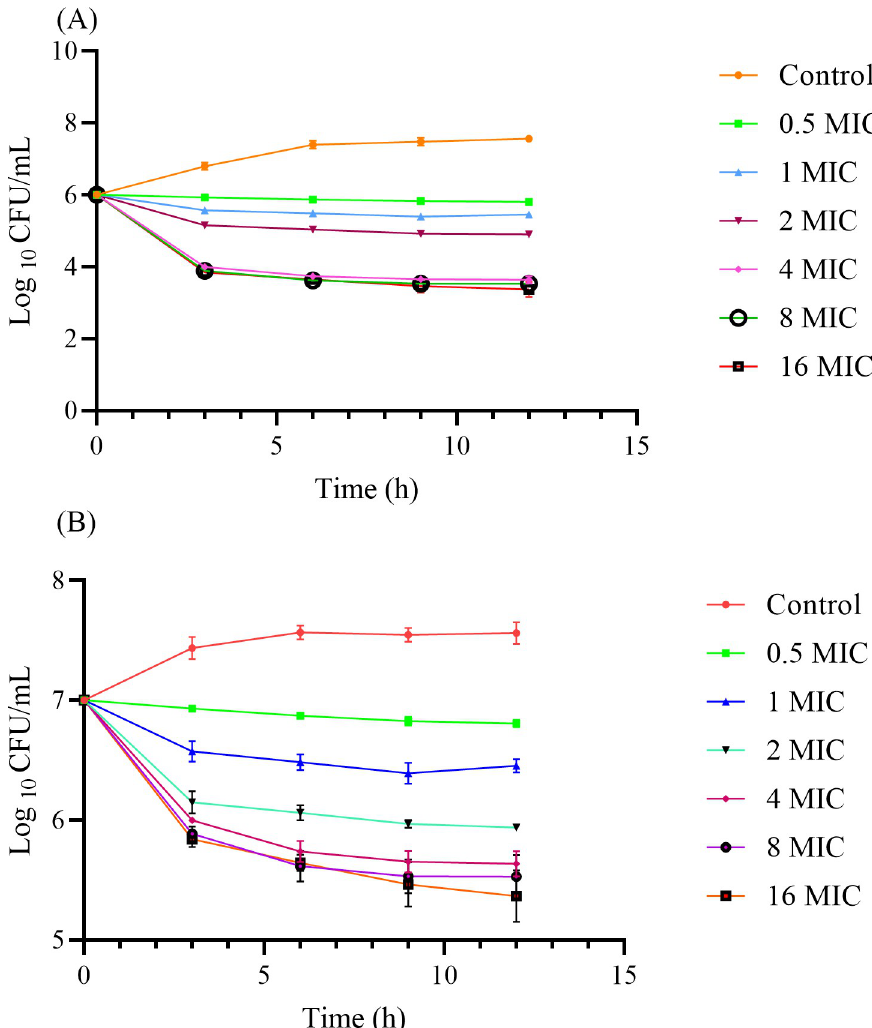
Fig 3. In vitro cefquinome killing curve against S . agalactiae 3–64. (A) Antibacterial effects begin at an initial inoculum of 10 6 CFU/mL. (B) Antibacterial effects begin at an initial inoculum of 10 7 CFU/mL. The bacterial population was measured at 0, 3, 6, 9, and 12 hrs by counting visible bacterial